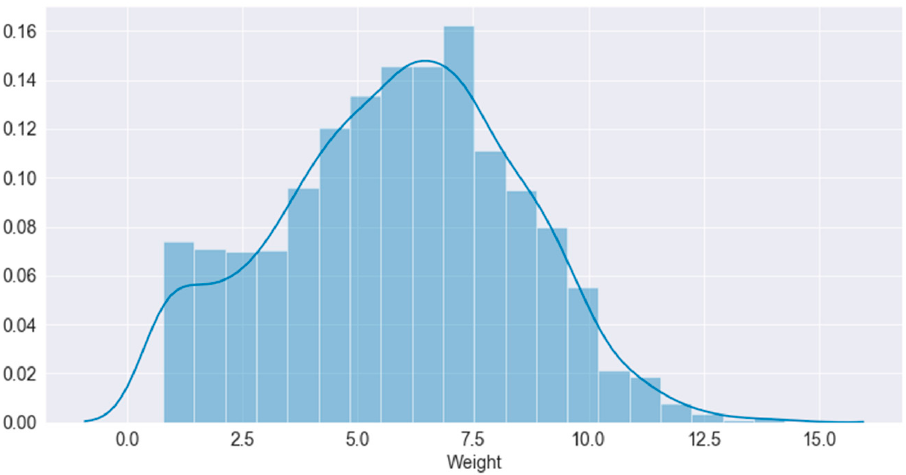
Figure 5. Weight distribution after logarithm scaling.